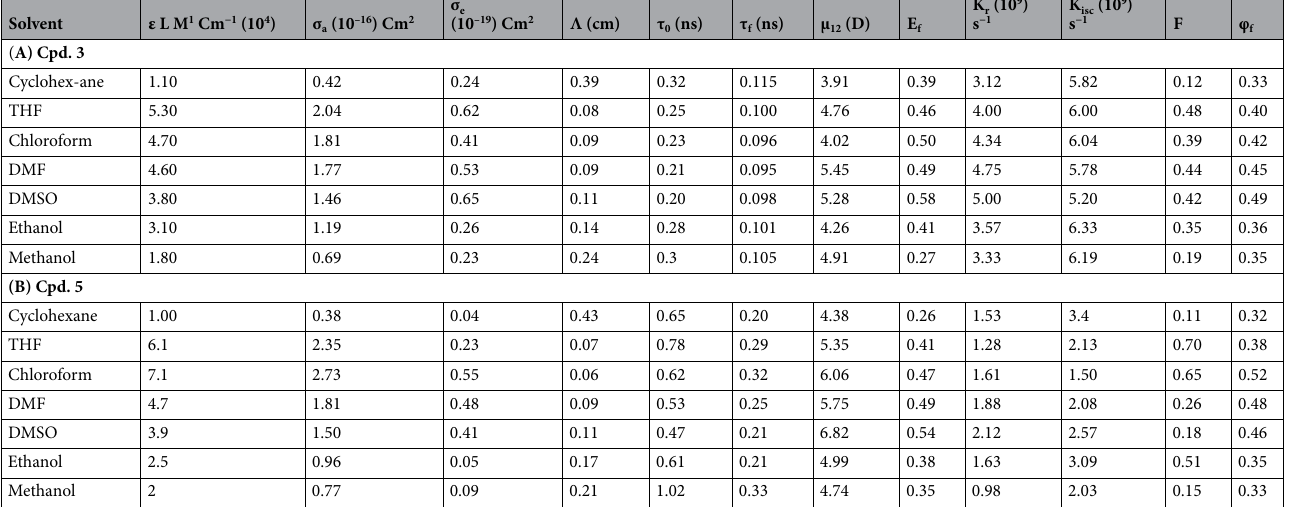
Table 4. (A, B) Photophysical parameters of compounds 3 and 5 , respectively; (ε) molecular extinction coefficient; σ a and σ e : absorption and emission cross-sections; (Λ) the attenuation length, (τ call ) calculated fluorescence lifetime,